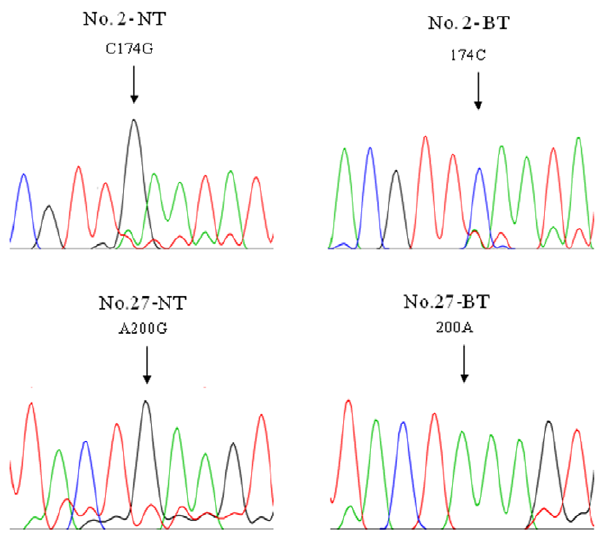
Figure 1. mtDNA substitution mutations only found in Barrett’s metaplasia tissue. Sequencing chromatograms showed Barrett’s metaplasia tissue (BT)-specific mtDNA mutations which were only observed in BT. Heteroplasmic mtDNA mutations were observed in HV2 from patient’s No. 2 and 27. These heteroplasmic mutations were not found in the corresponding adjacent normal mucosal tissue (NT).